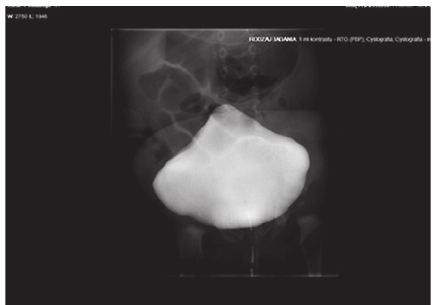
Figure 4: Cystography showed enlarged, hypotonic urinary